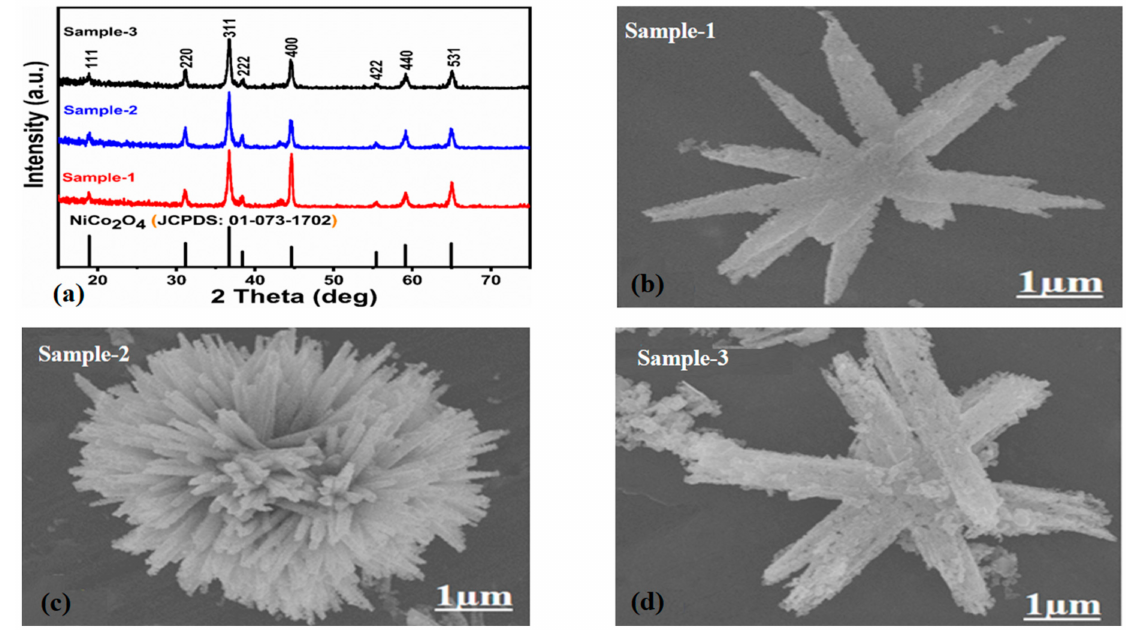
Figure 1. ( a ) XRD patterns of NiCo 2 O 4 samples prepared with various concentrations of urea (Samples 1–3), ( b – d ) effect of various urea concentrations (Samples 1–3) on the morphology of NiCo 2 O 4